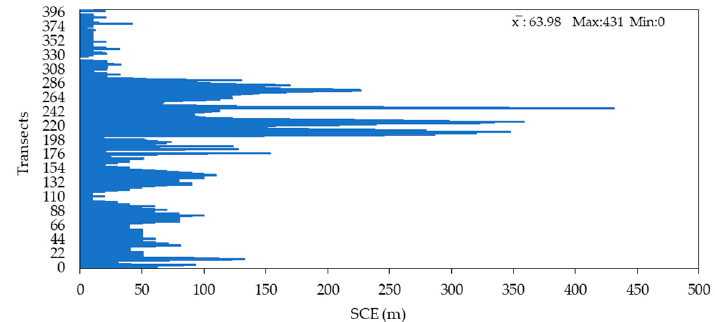
Figure 13. SCE calculation curve of Subarnarekha’s estuarine section under Delta Sub-basin. The numbering of the transects increases towards the East.